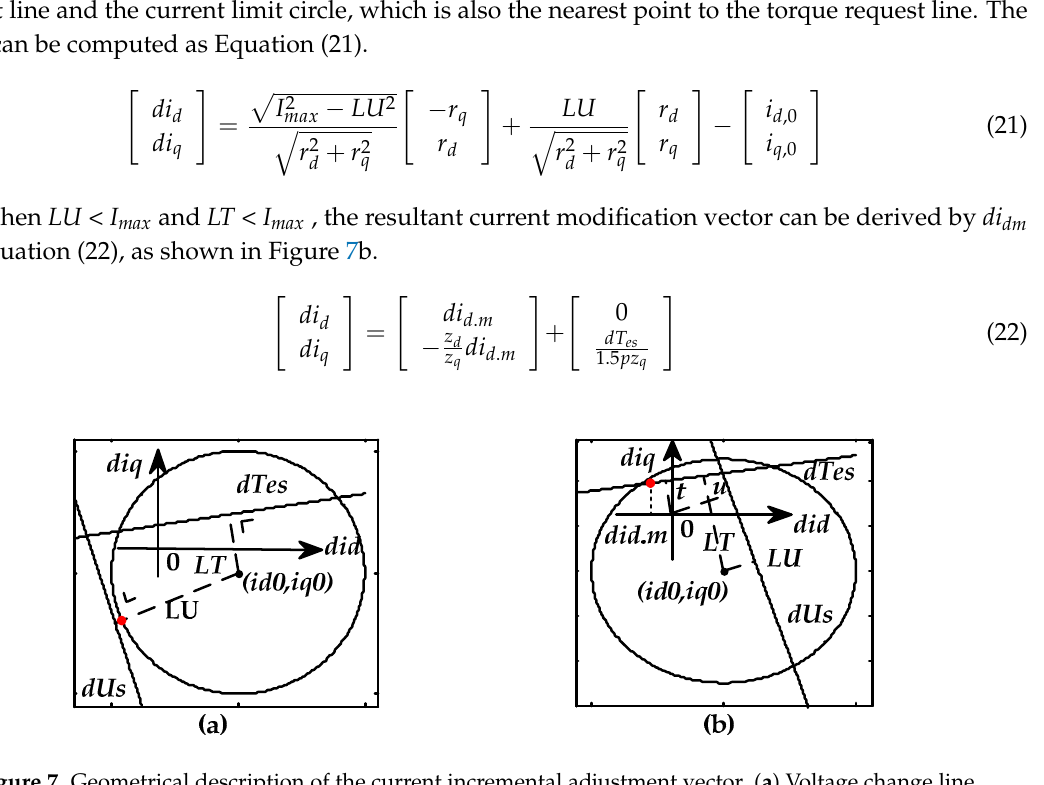
Figure 7. Geometrical description of the current incremental adjustment vector. ( a ) Voltage change line beyond the current limit circle; ( b ) the crosspoint of the torque and voltage request line located in the right hand side of the optimal current point.